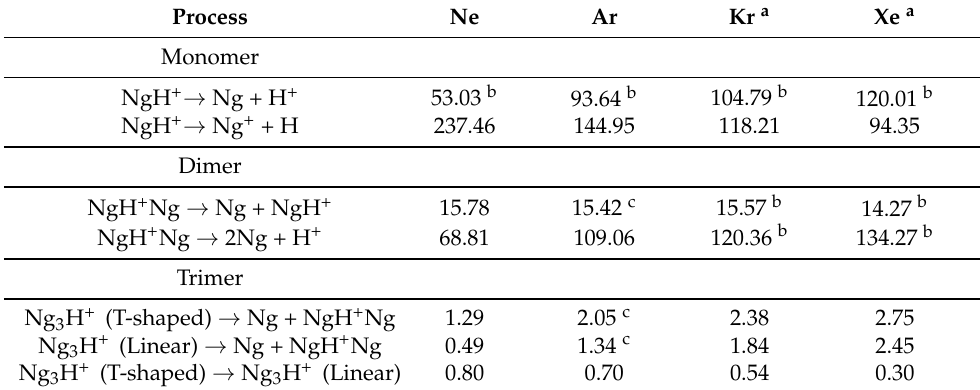
Table 2. CCSD(T)/CBS//CCSD(T)/aug-cc-pVTZ a dissociation and isomerization energies in